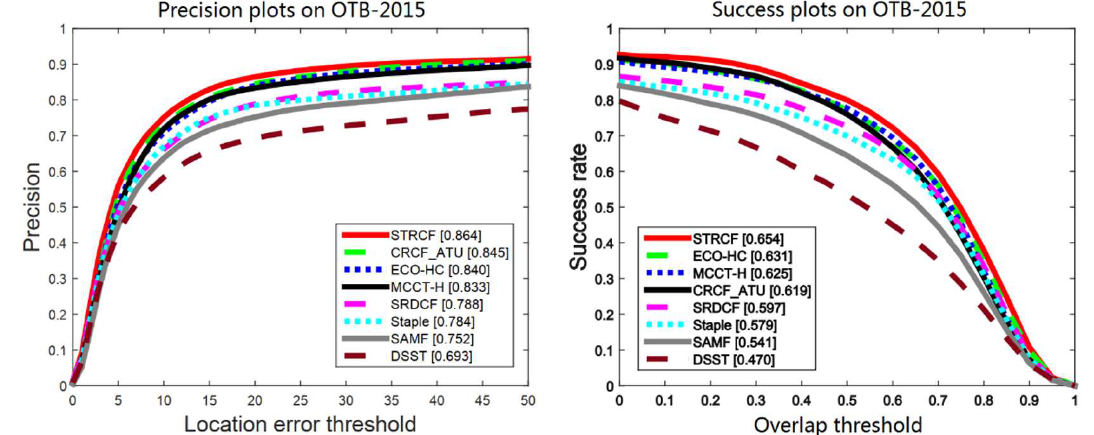
Figure 5. Comparison between CRCF_ATU tracker and existing trackers on OTB-2015.